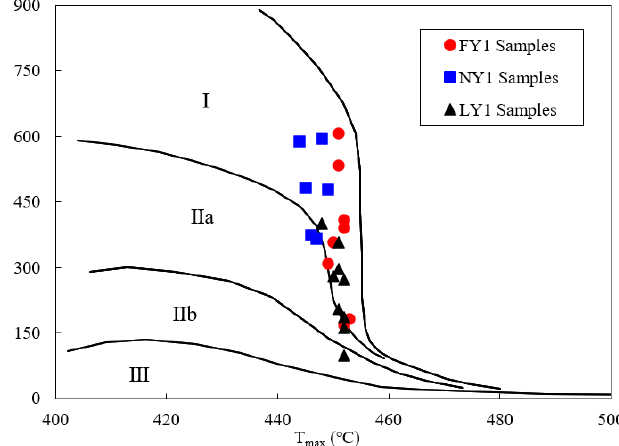
Figure 1. Correlations of HI and T max for the studied samples, showing their kerogen types. Classification of kerogen types was modified from Wu et al. [45].